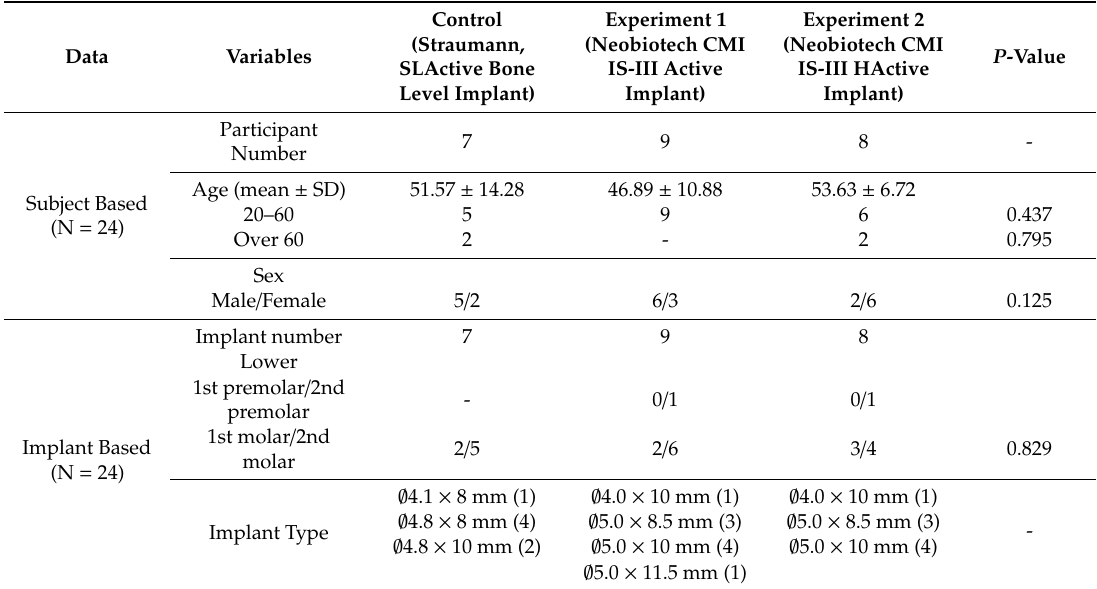
Figure 5. Flow diagram of this study. Table 1. Demographic data of study participants.